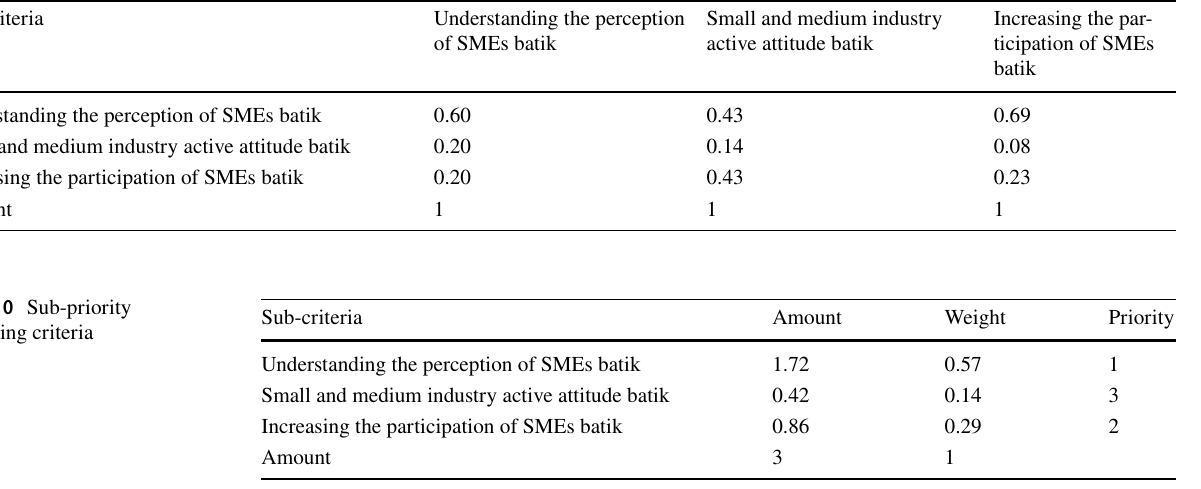
*The amount is indicated the total of the normalization matrix i to j for each sub-criteria in